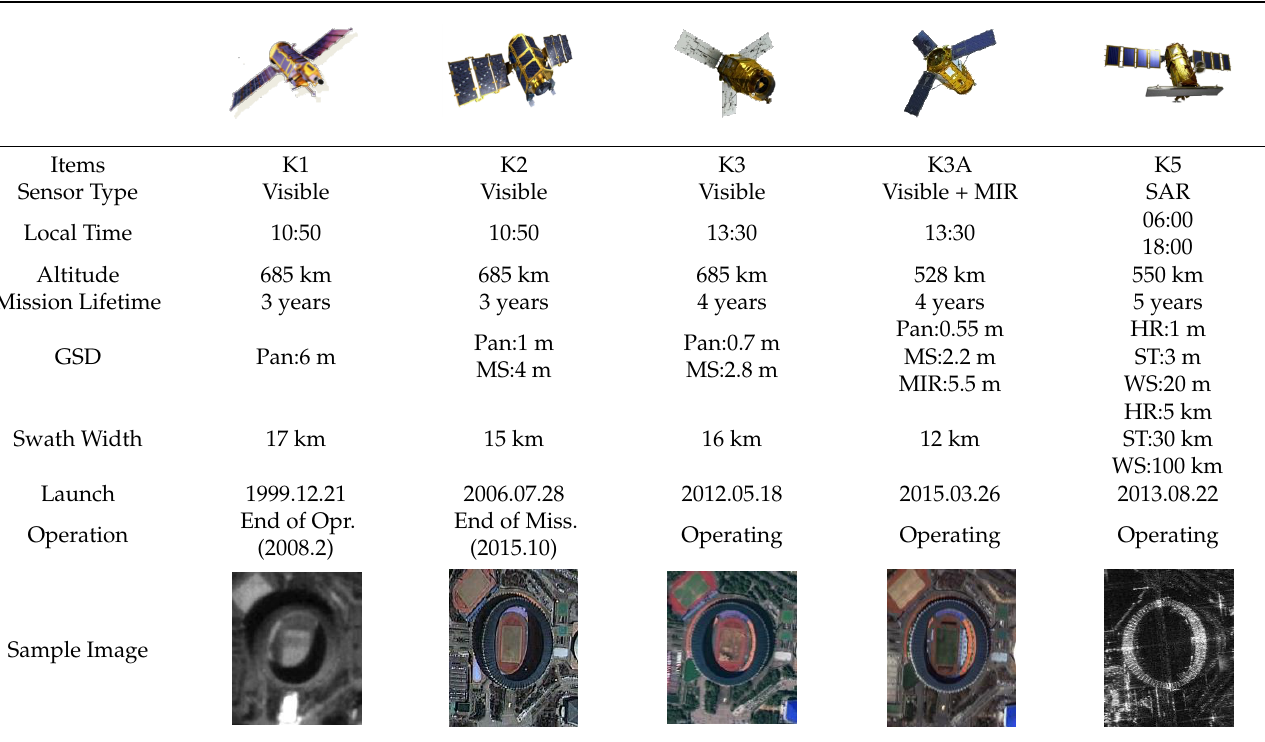
Table 1. KOMPSAT Series Specifications and Sample Images.